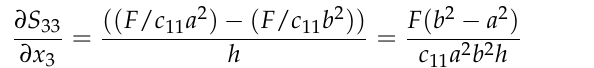
Figure 4. Schematic of point ‐ ring method used to apply strain gradient.